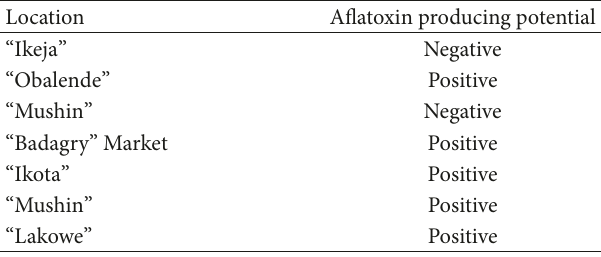
Table 4: Aflatoxigenicity of fungal isolates from cashew nuts from Lagos State on Neutral Red Desiccated Coconut Agar (NRDCA).